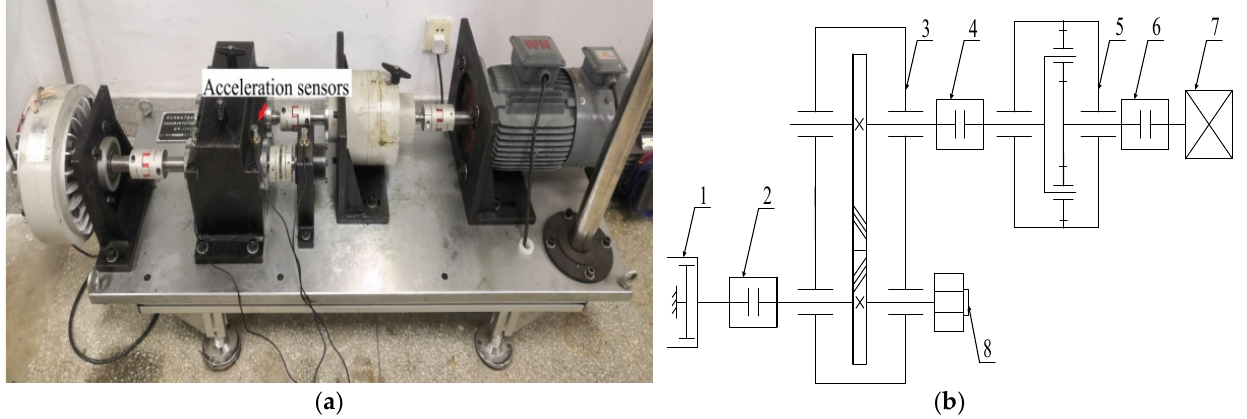
Figure 4. ( a ) The experimental rig and the location of the acceleration sensors. ( b ) The structure of test rig: 1—magnetic powder brake, 2—acceleration sensor, 3—helical gearbox, 4—shaft coupling, 5—planetary gearbox, 6—bearing bracket, 7—motor, and 8—outer bearing bracket. Table 3. Bearing parameters.